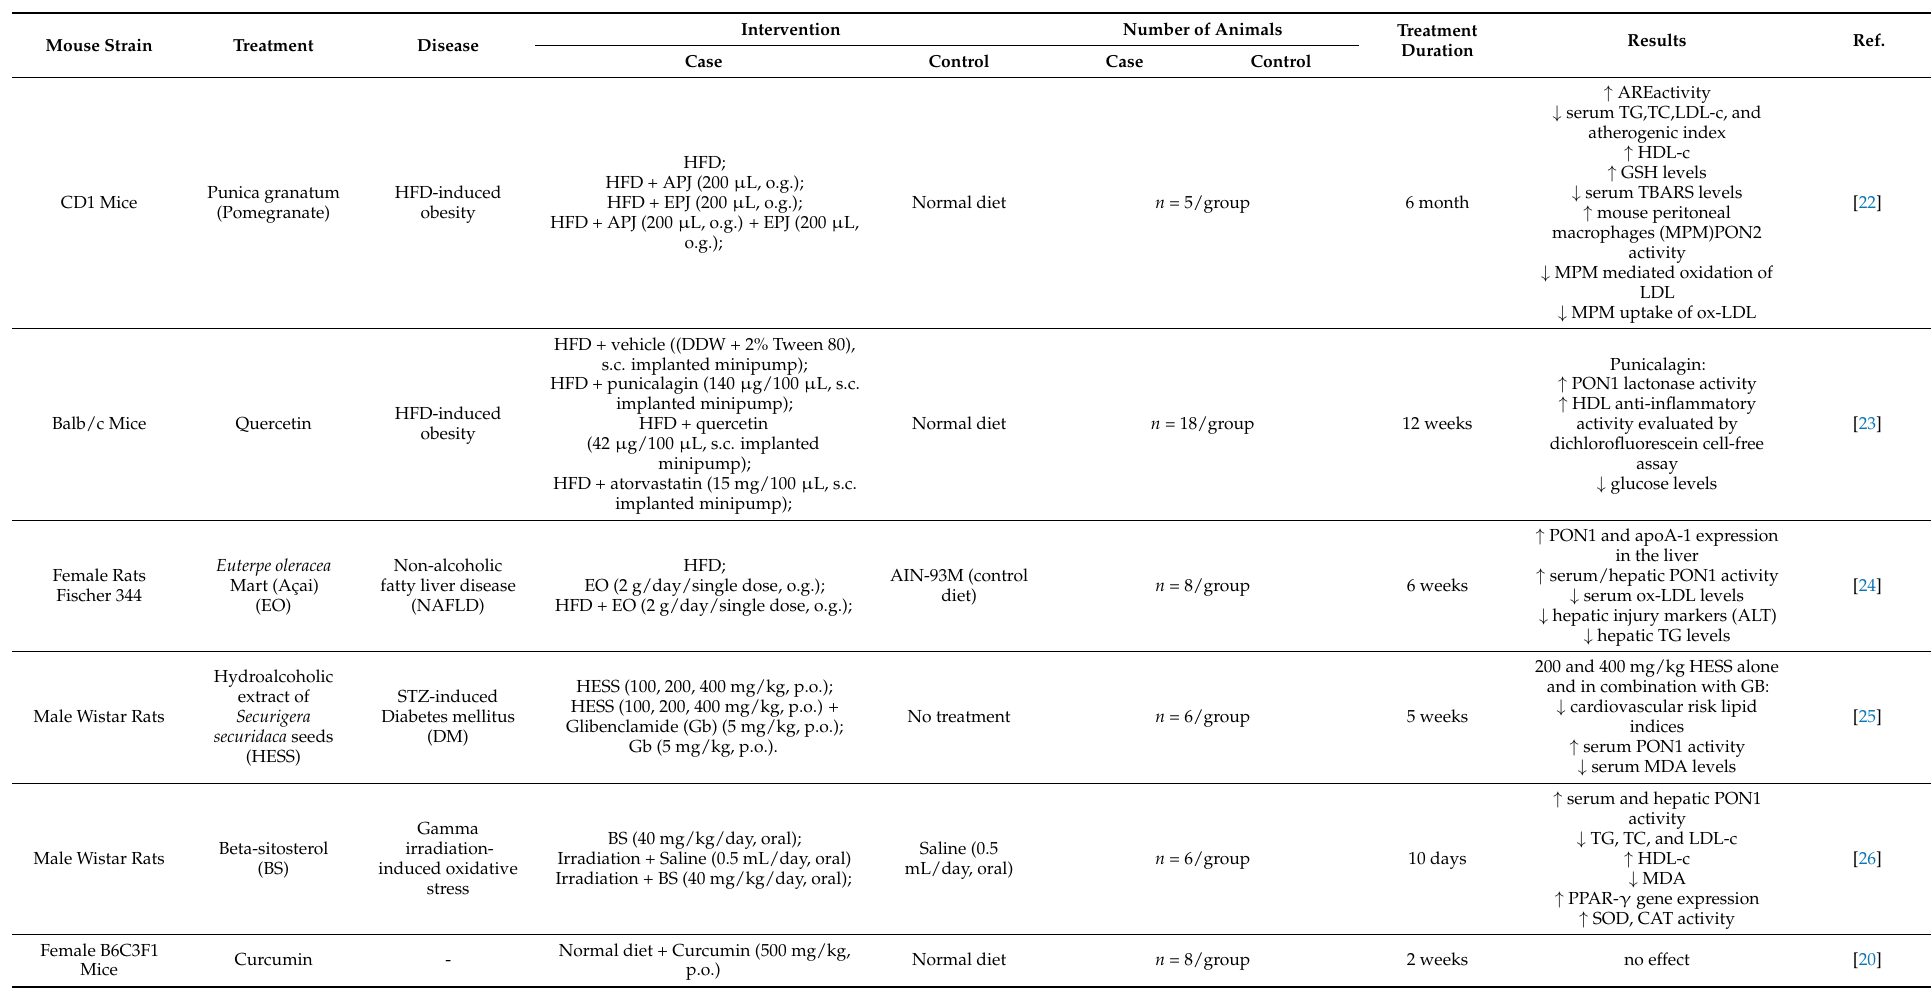
Table 2. Effects of phytochemicals on PON1: in vivo